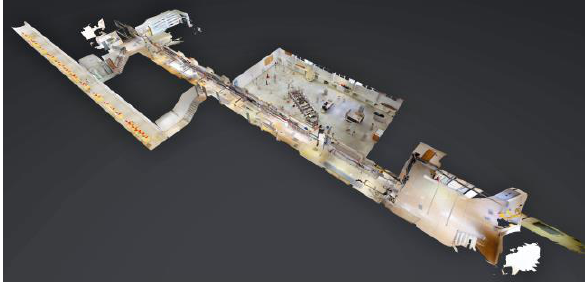
Figure 7. View of the 3D data acquired by the Matterport